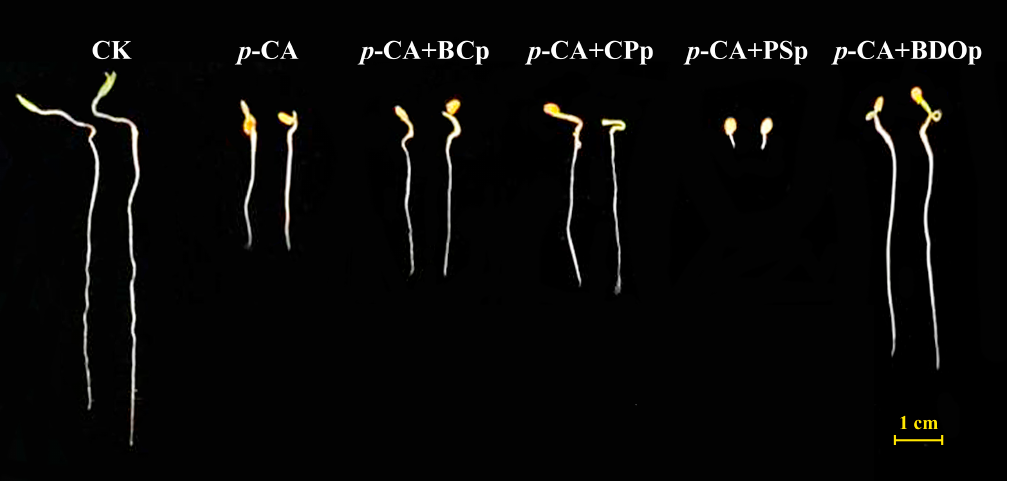
Figure 1. The phenotypes of tomato seeds at 7 days of germination under different treatments. Abbreviations: CK, control check with ddH 2 O; p -CA, stress treatment with 10 mL 400 mg/L p -coumaric acid; p -CA + BC P , 10 mL 400 mg/L p -coumaric acid with 0.0250 g biochar particles; p -CA